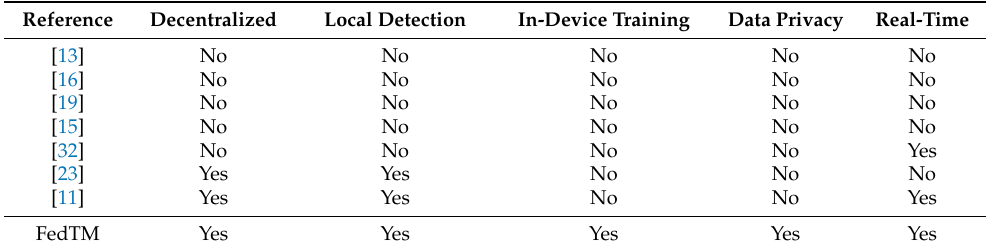
Table 1. Related works